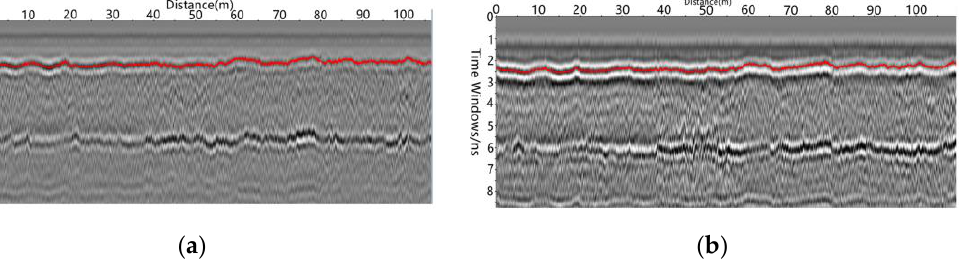
Figure 2. Scanning radar image by common mid-point method. ( a ) Combined asphalt base interface reflection signal of adjacent antennas. ( b ) Reflection signal of asphalt base interface of antenna combination at a distance of X meters.